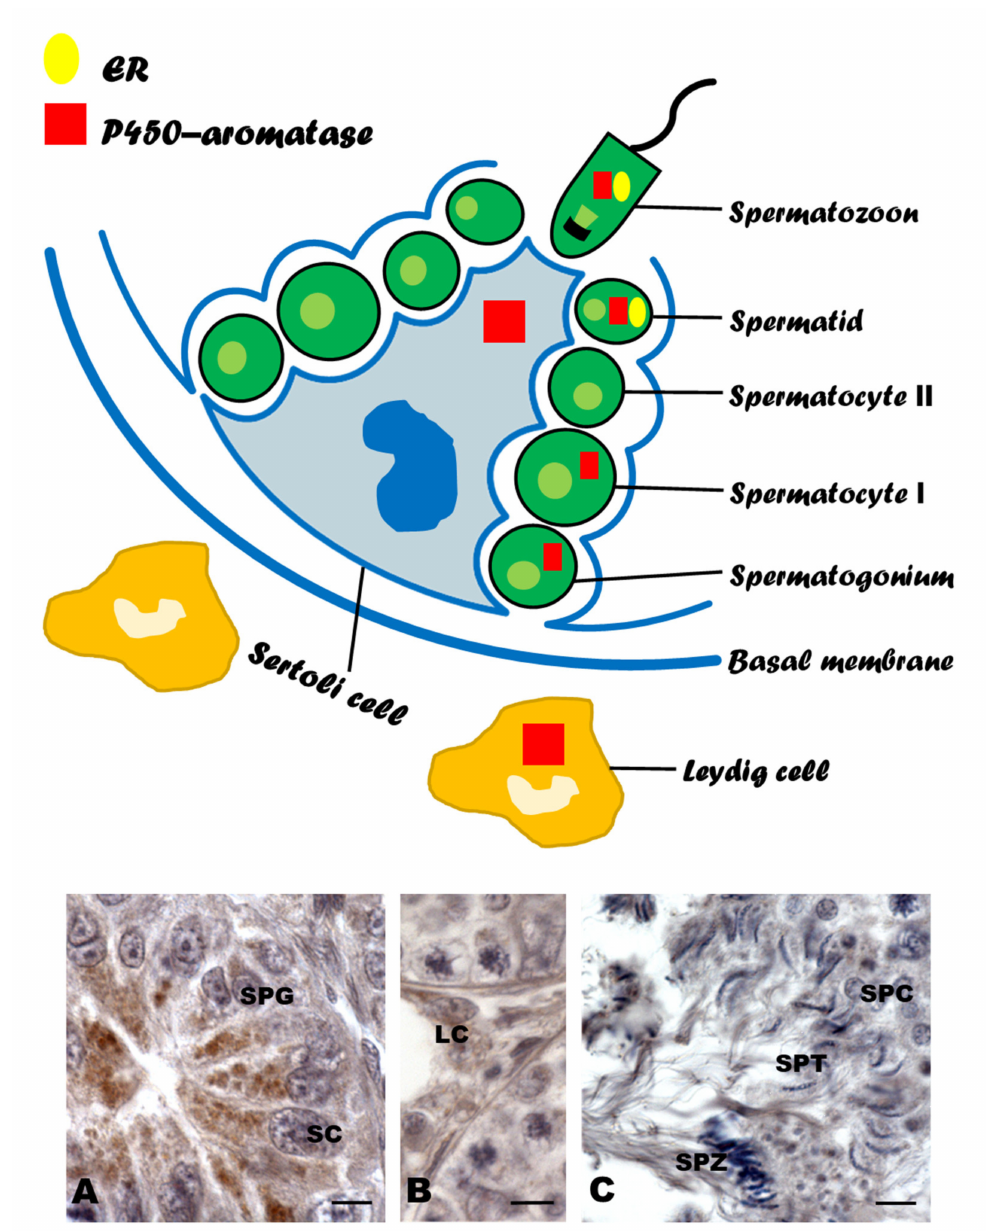
Figure 2. Schematic summary of estrogen receptor (ER) and P450 aromatase localizations in the testis of Amphibians, Reptiles and Birds. ( A – C ): Immunolocalization of P450 aromatase in Podarcis sicula . Signal has been localized: ( A ) spermatogonia (SPG) and Sertoli cells (SC); ( B ) Leydig cells (LC); ( C ) spermatocytes (SPC), spermatids (SPT), and spermatozoa (SPZ) (from [41]). Scale bars = 5 µ